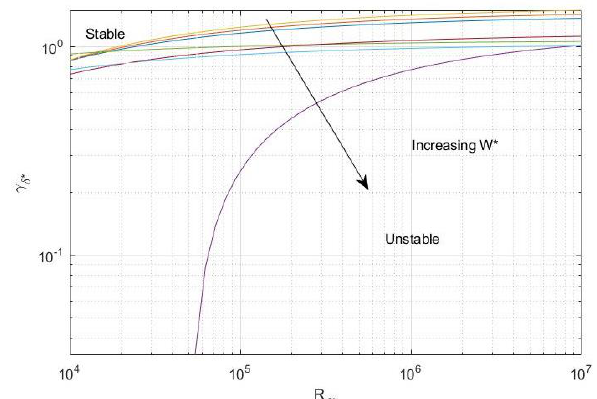
Figure 15. Plot illustrating predictions of asymptotic neutral wavenumber γ δ ∗ against R δ ∗ for type I modes for T s = 0.05 with W ∗ = ( − 0.35 ) to ( 0.55 ) . Increasing W ∗ shifts the curves vertically downwards.